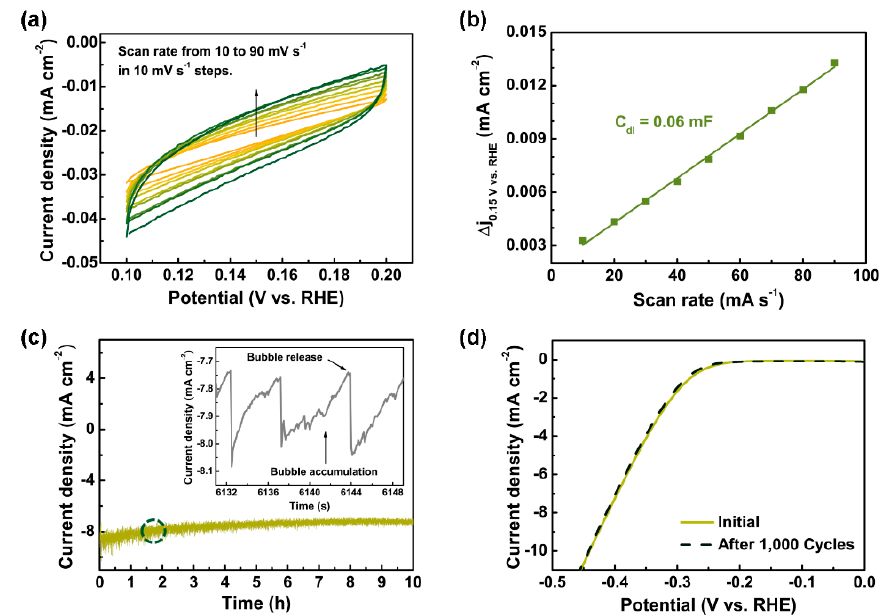
Figure 5. ( a ) CV response of MoS 2 tested at various scan rates ranging from 10 to 90 mV s − 1 in the potential range of 0.1–0.2 V. ( b ) Capacitive current at 0.15 V with respect to the scan rate for the MoS 2 film in the 0.5 M H 2 SO 4 electrolyte. ( c ) Time dependence of the current density for 10 h, under the static overpotential corresponding to a current density of 10 mA cm − 2 based on the recorded value in the polarization curve. After 10 h, the current density was 83% of the initial value. Inset: magnified image of the area indicated by the dashed circle. ( d ) Cycling stability test results, indicating negligible current loss after 1000 cycles. The light and dark green lines are the polarization curves of the sample before and after cycling, respectively.